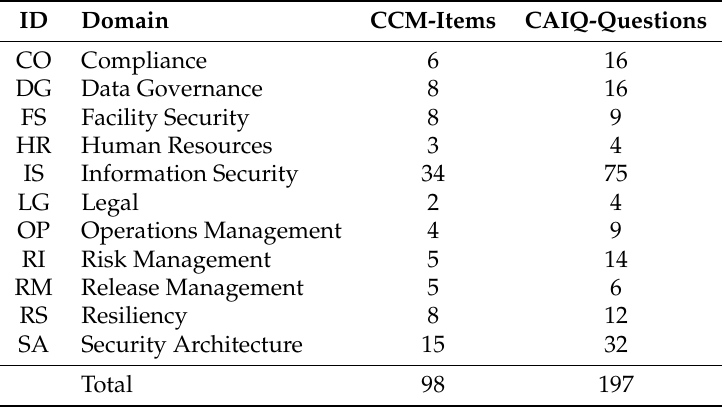
Table 2. Cloud Controls Matrix (CCM)-Item and CAIQ-Question Numbers per Domain (version 1.1).